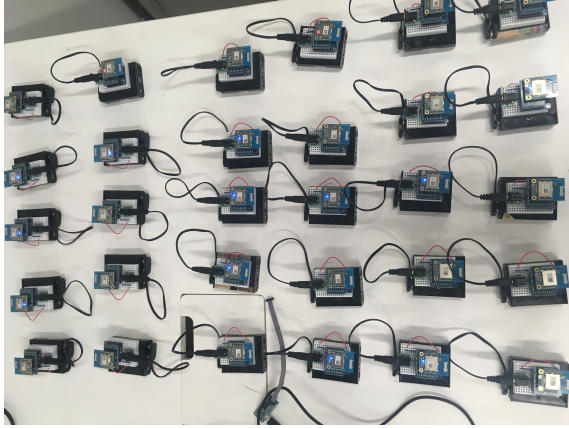
Figure 7. Cognitive-IoT prototypes.